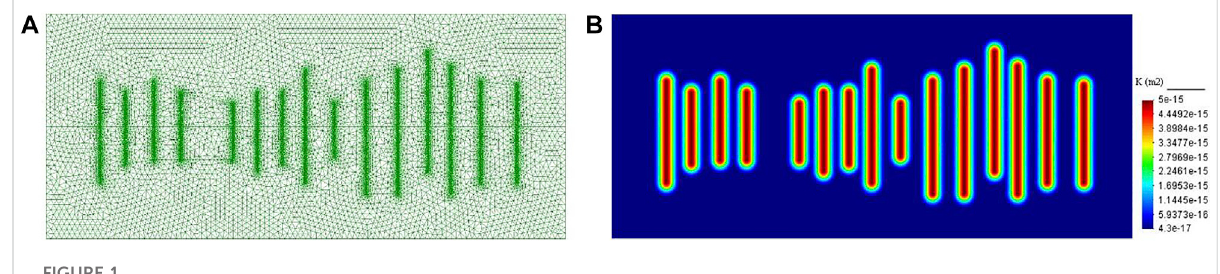
FIGURE 1 Numerical model and permeability distribution in the stimulated area. (A) Grid of the numerical model; (B) Permeability distribution in the stimulated